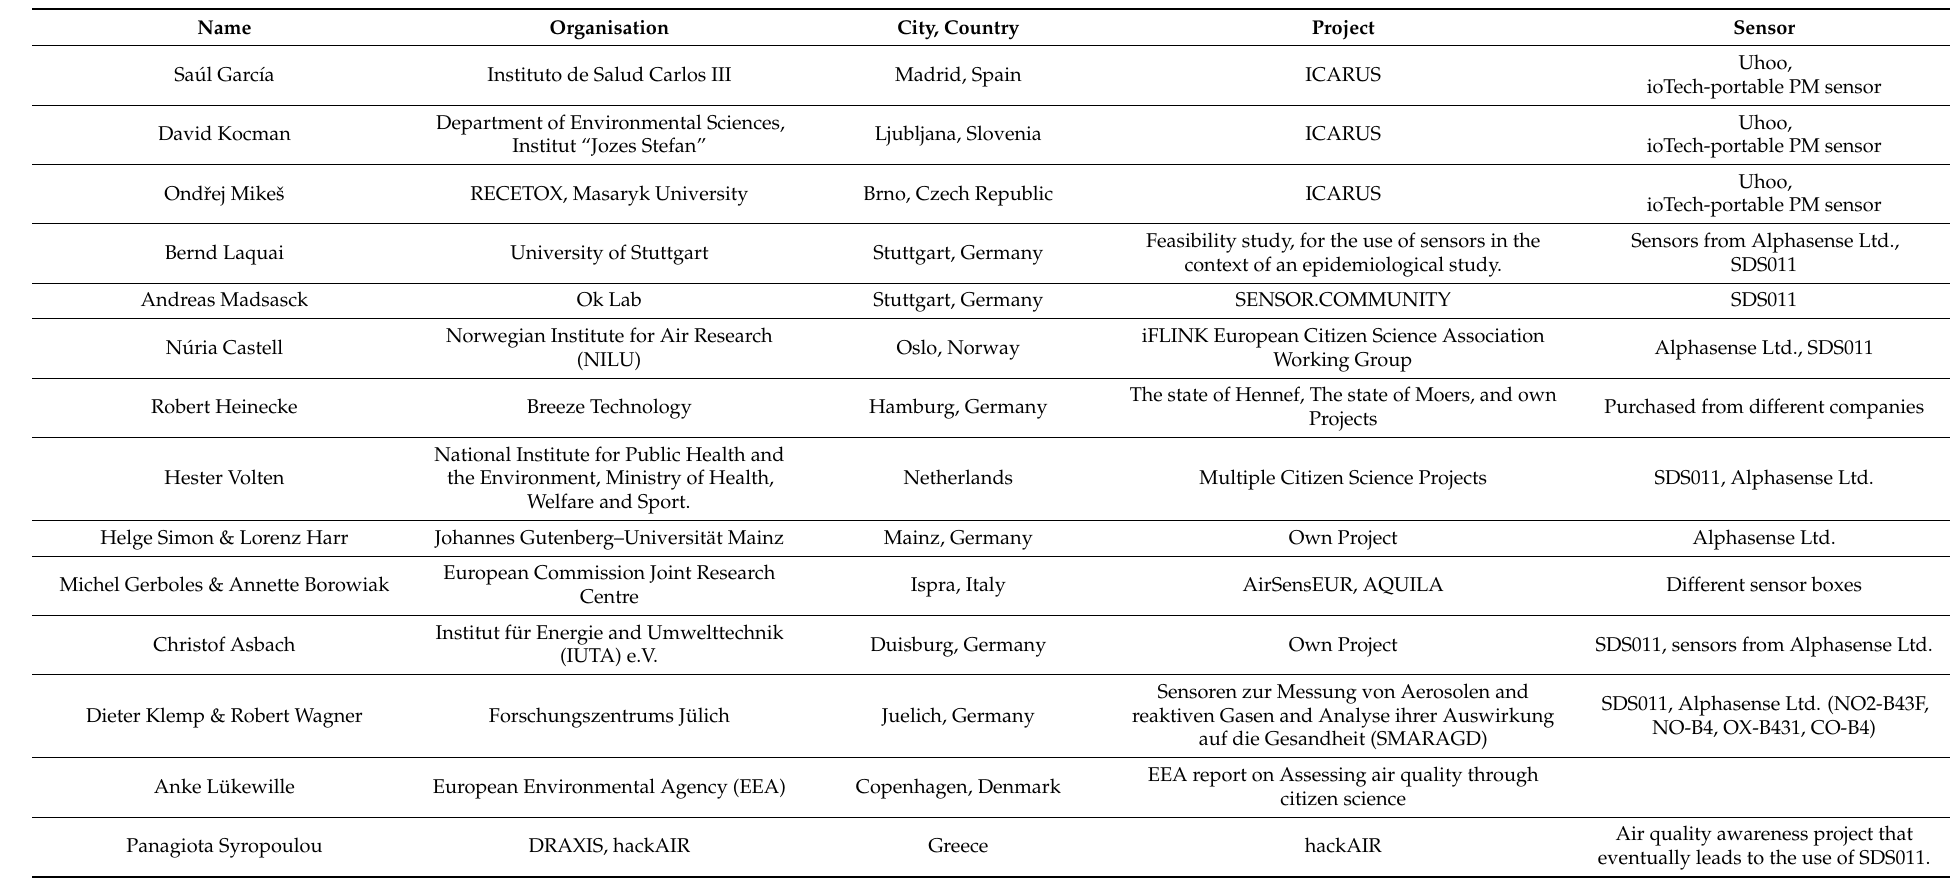
Table A1. Experts contacted as a part of a project on developing a communication strategy for citizen science projects and the general public on the usage of LCS for the German Environmental Agency (Umweltbundesamt,